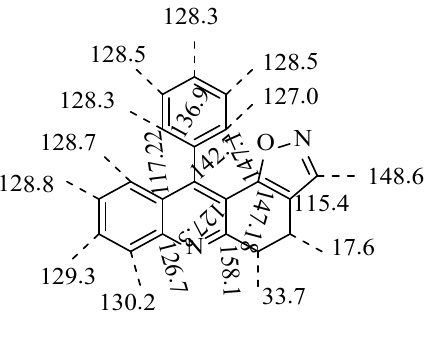
Figure 6: Summary of Carbon d Values